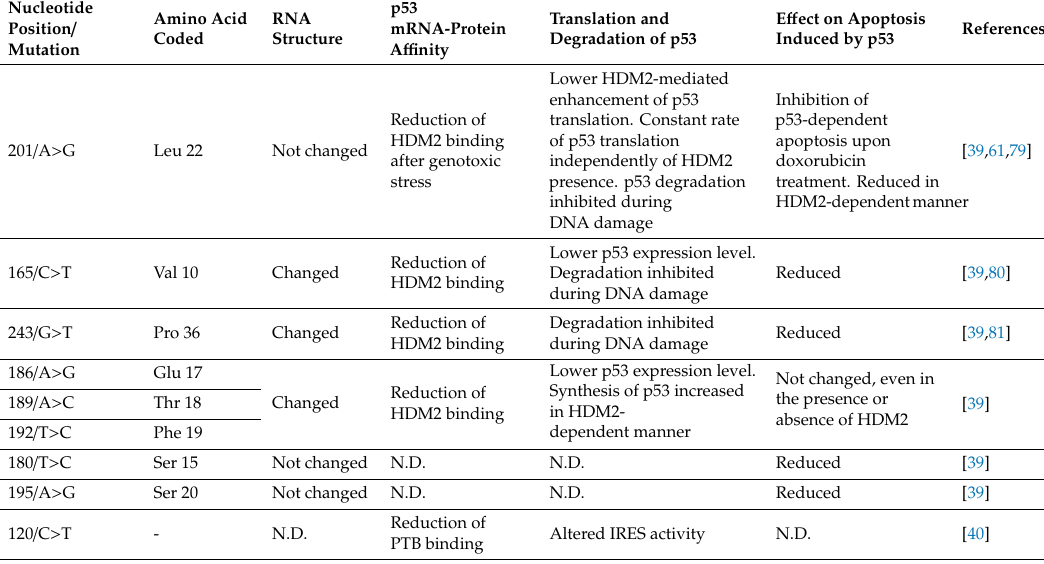
Table 2. The influence of a single nucleotide polymorphism (SNP) and synonymous mutations within the 5 (cid:48) -terminal region of p53 mRNA on p53